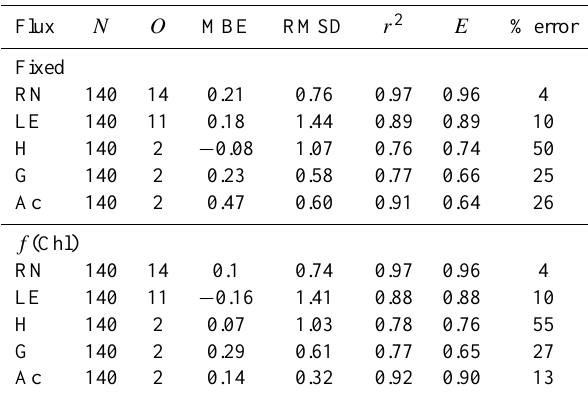
Table 2. Planting density (plantsm − 2 ). NA: not available.